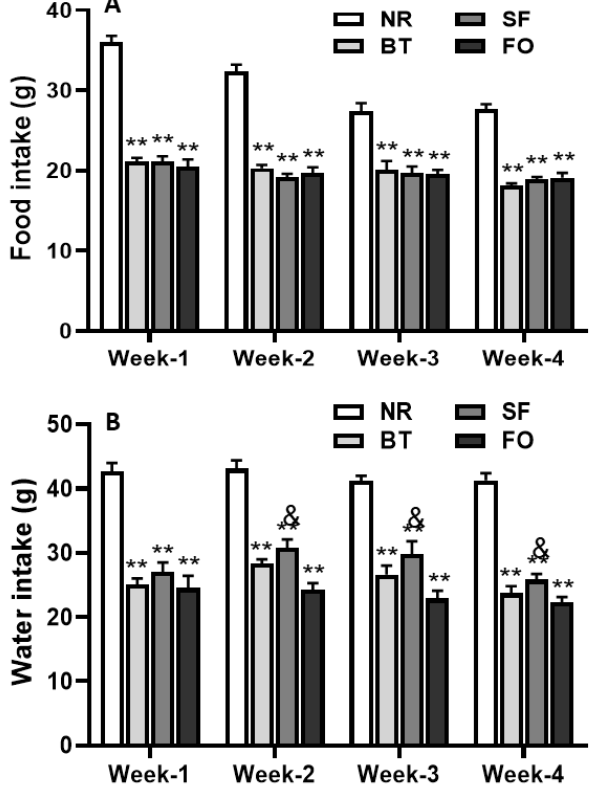
Figure 2. Daily food ( A ) and water ( B ) intake of each week in rats during 4-week feeding period with either normal rodent diet (NR, 4% fat) or 10% high-fat diets including beef tallow (BT), safflower oil (SF), or fish oil (FO), respectively. Values are expressed as mean ± SE.; n = 6, ** p < 0.01 vs. NC; & p < 0.05 vs. FO .